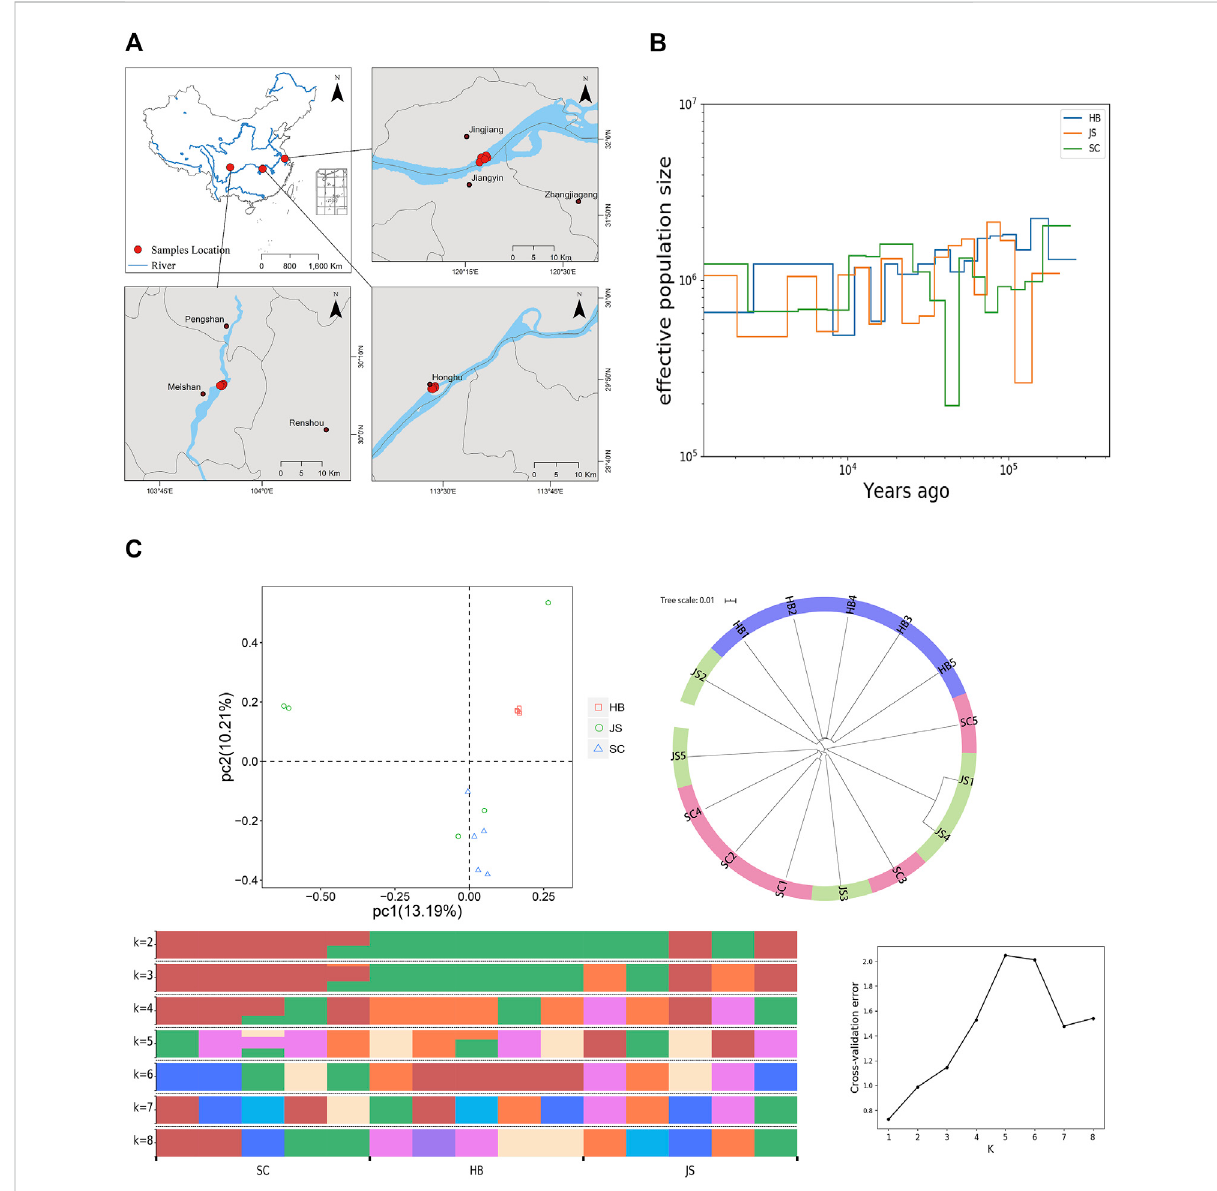
FIGURE 4 Population evolution of P. vachelli . (A) Geographical distribution of P. vachelli . (B) Demographic histories of P. vachelli . The blue line represents Hubei P. vachelli population (HB), the orange line represents Jiangsu P. vachelli population (JS), and the green line represents Sichuan P. vachelli population (SC). (C) Population structure of P. vachelli , including principal component analysis (PCA), phylogenetic tree and genetic structure analysis (different colors indicate different genetic